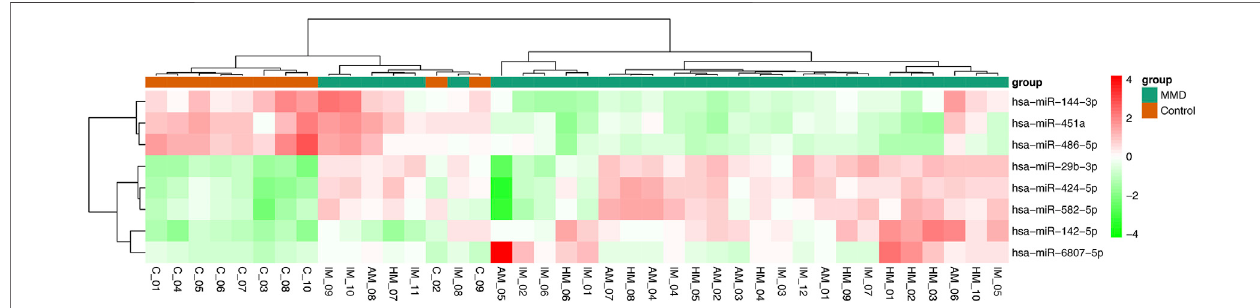
FIGURE 1 | Heat map of differentially expressed miRNAs between MMD patients and healthy controls. In this analysis, 8 miRNAs were found to be differentially expressed, with 5 upregulated (miRNA-142-5p, miRNA-29b-3p, miRNA-424-5p, miRNA-582-5p, miRNA-6807-5p) and 3 downregulated (miRNA-144-3p, miRNA- 451a,